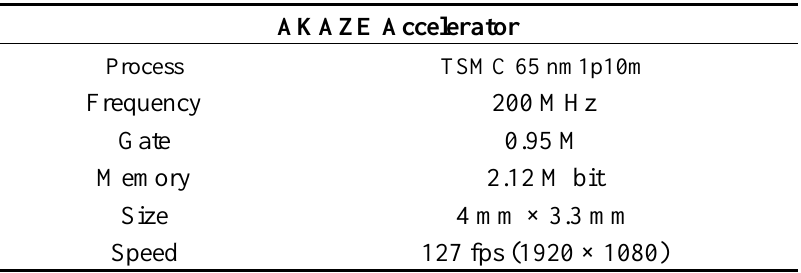
Table 4. Characteristics of the proposed